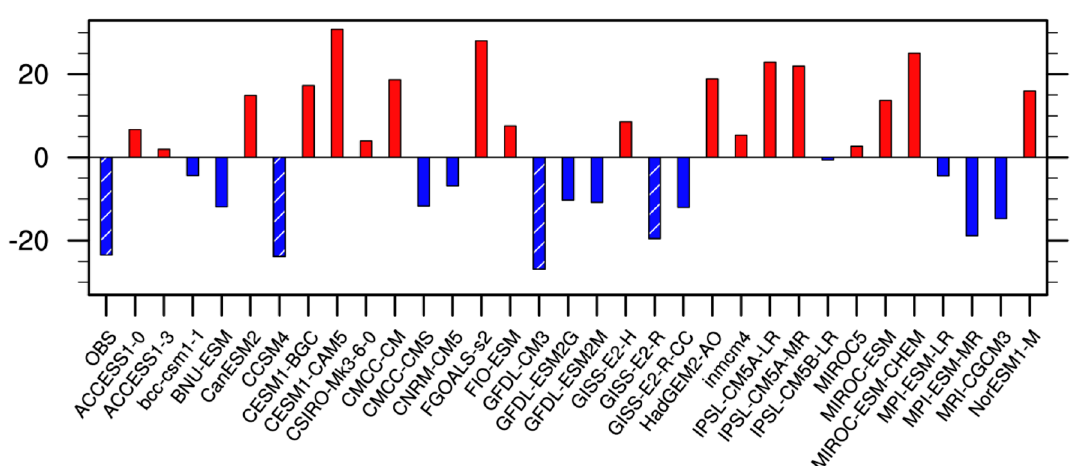
Figure 2. Linear trend of precipitation (unit: mm month −1 55 yr −1 ) in August averaged over the TCZ during 1951–2005 in the observation and 32 CMIP5 models. The observation trend is calculated based on the average precipitation derived from CRU TS version 4.01 21 (URL: http://cruda ta.uea.ac.uk/cru/data/hrg/cru_ts_4.01/) and GPCC V7 22 (URL: https ://psl.noaa.gov/data/gridd ed/data.gpcc.html). Bars with slashes indicate linear trends exceeding the 90% confidence level. This Figure is created by the NCAR Command Language (version 6.4.0 & URL: http://www.ncl.ucar.edu/Downl oad) 27